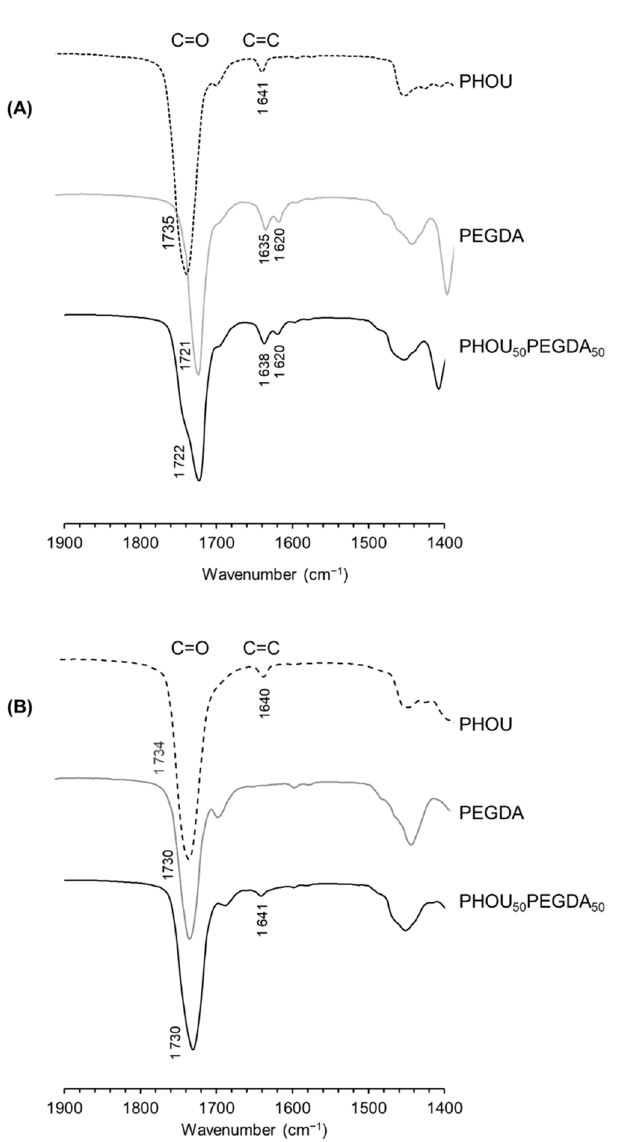
Figure 2. FTIR spectra of PHOU, PEGDA and PHOU 50 PEGDA 50 before irradiation ( A ) and after irradiation ( B ). Table 2. Characteristics of the networks.